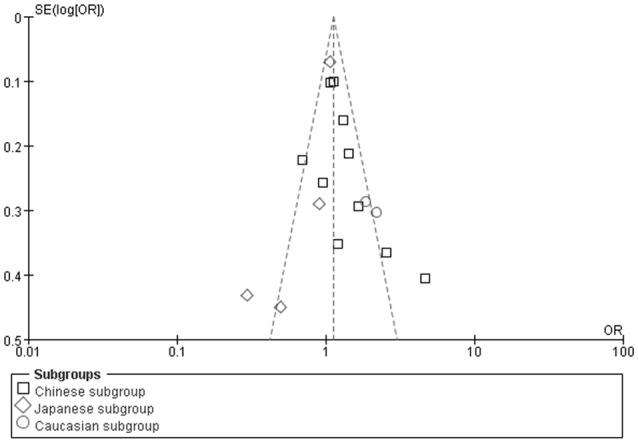
The funnel plot for the association of EH with ADRB3 gene Trp64Arg polymorphism under an additive genetic model (A vs. T). The horizontal and vertical axis correspond to the OR and confidence limits. OR: odds ratio.